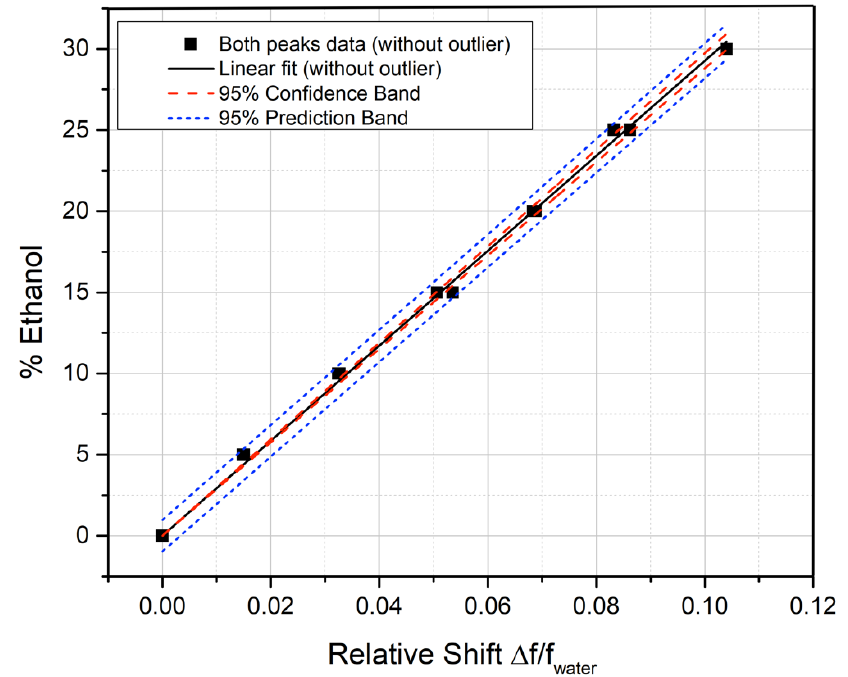
Figure 8. Confidence band and prediction band for the fit of both peaks without the outlier.